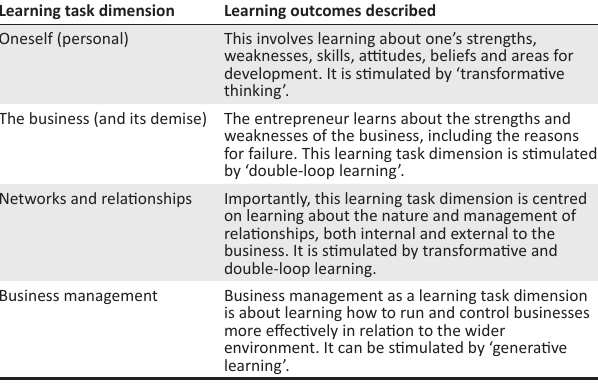
TABLE 1: The entrepreneurial learning task outcomes of